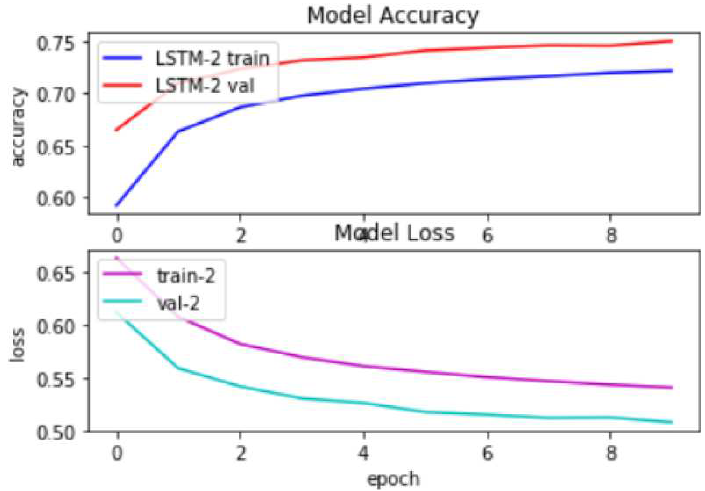
Fig. 10 Experimental results of LSTM sentiment analysis.